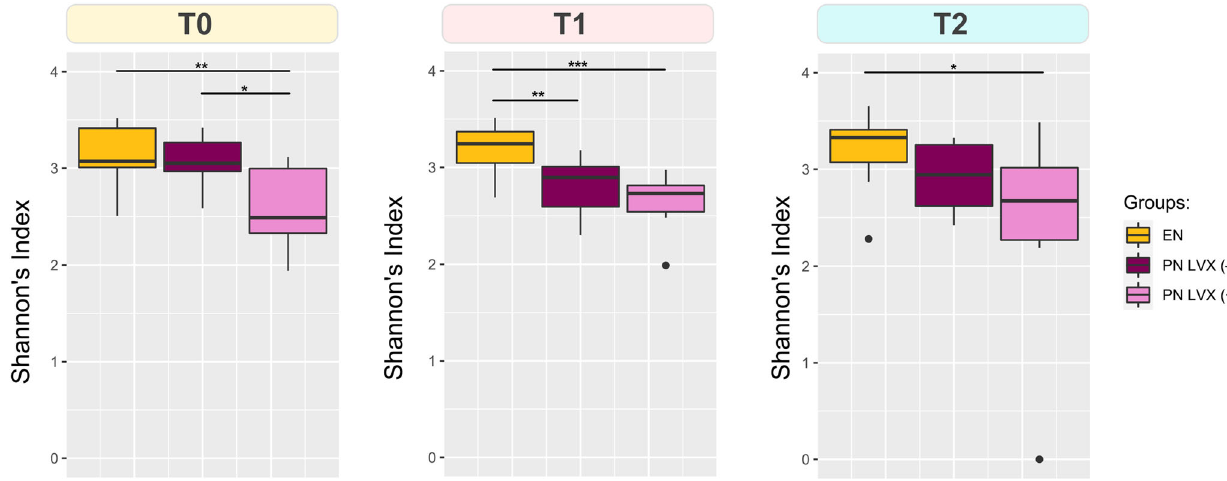
Fig. 2 Levo fl oxacin prophylaxis results in a sustained reduction in alpha diversity. Boxplots representing the distribution of alpha diversity estimated with the Shannon index for each patient group (EN, PN LVX ( – ), PN LVX ( + )) before (T0) and at 2 time points after HSCT (T1 and T2). Signi fi cant differences between groups are shown (Wilcoxon rank sum test with FDR correction, *** p < 0.001, ** p < 0.01, * p < 0.05). n = 10 biologically independent samples for each timepoint. Whiskers represent range between the fi rst quartile (Q1) and the third quartile (Q3). Data points outside the boundary of the whiskers are plotted as